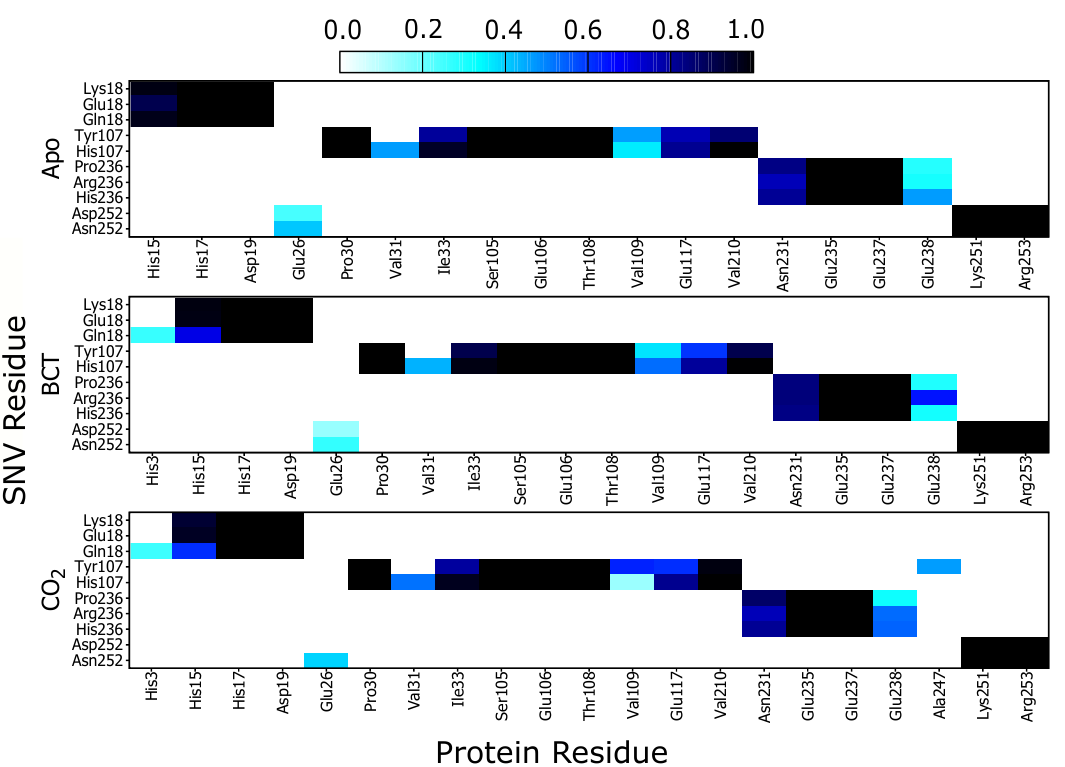
Figure 6. Heat map presenting the contact map weighted interactions between the respective SNV residues in; K18E, K18Q, H107Y, P236H, P236R and N252D with neighboring CA-II